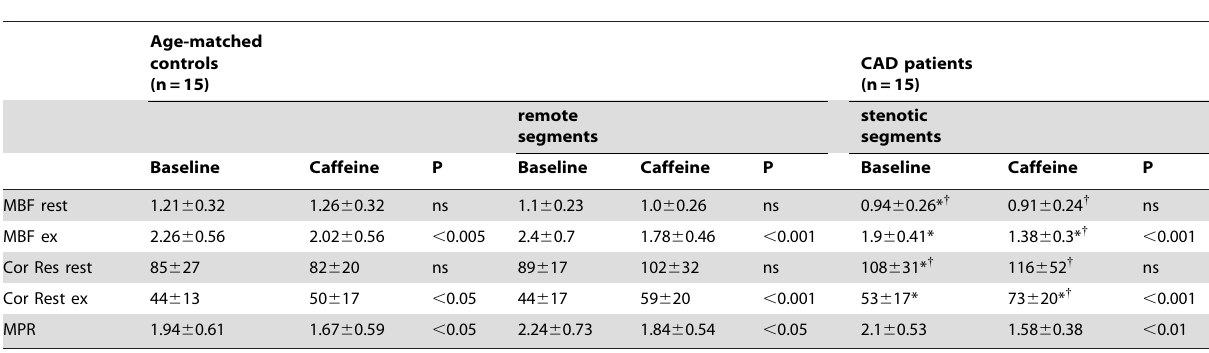
Table 2. Myocardial Blood Flow, Coronary Resistance and Flow Reserve.